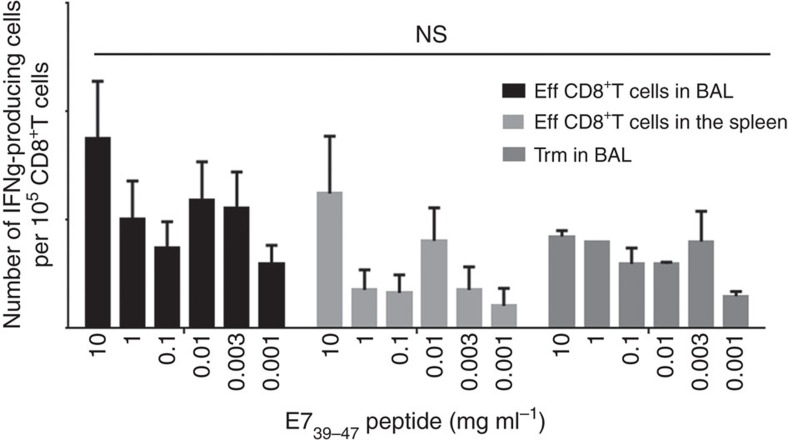
Comparative functional analysis of effector CD8+T cells and Trm.Effector CD8+T cells from BAL and spleen and Trm from BAL were sorted 7 days after the boost i.n. immunization with STxB-E7. Cells were pulsed or not with a set of concentrations of the E739–47 peptide and 24 h later IFNγ Elispot was performed. Experiments were reproduced two times and statistical analysis was performed with a two-way analysis of variance (ANOVA). Error bars indicates s.e.m. NS, not significant.